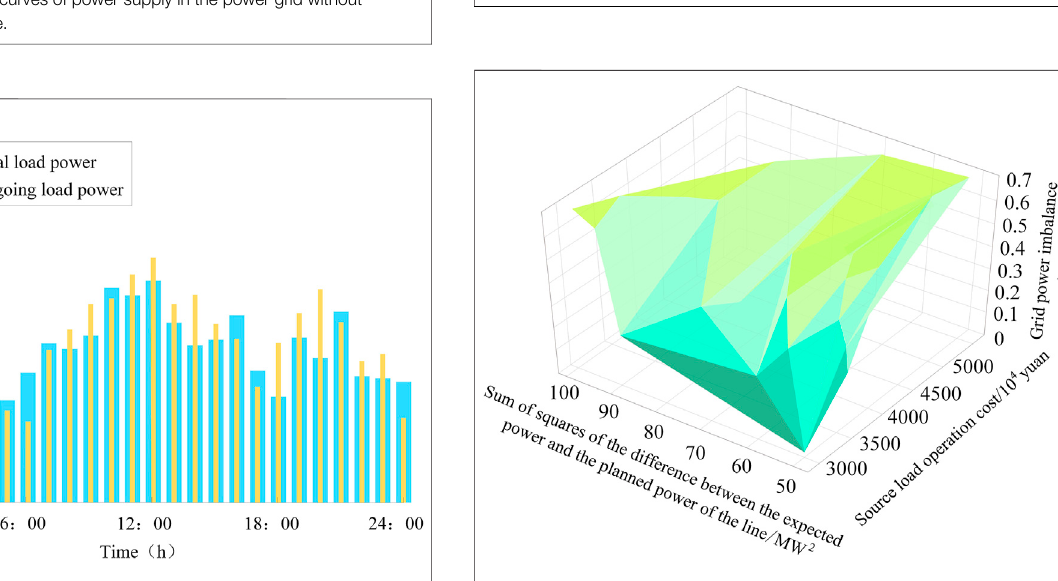
FIGURE 5 | Variation curves of load power in the power grid without energy storage device.